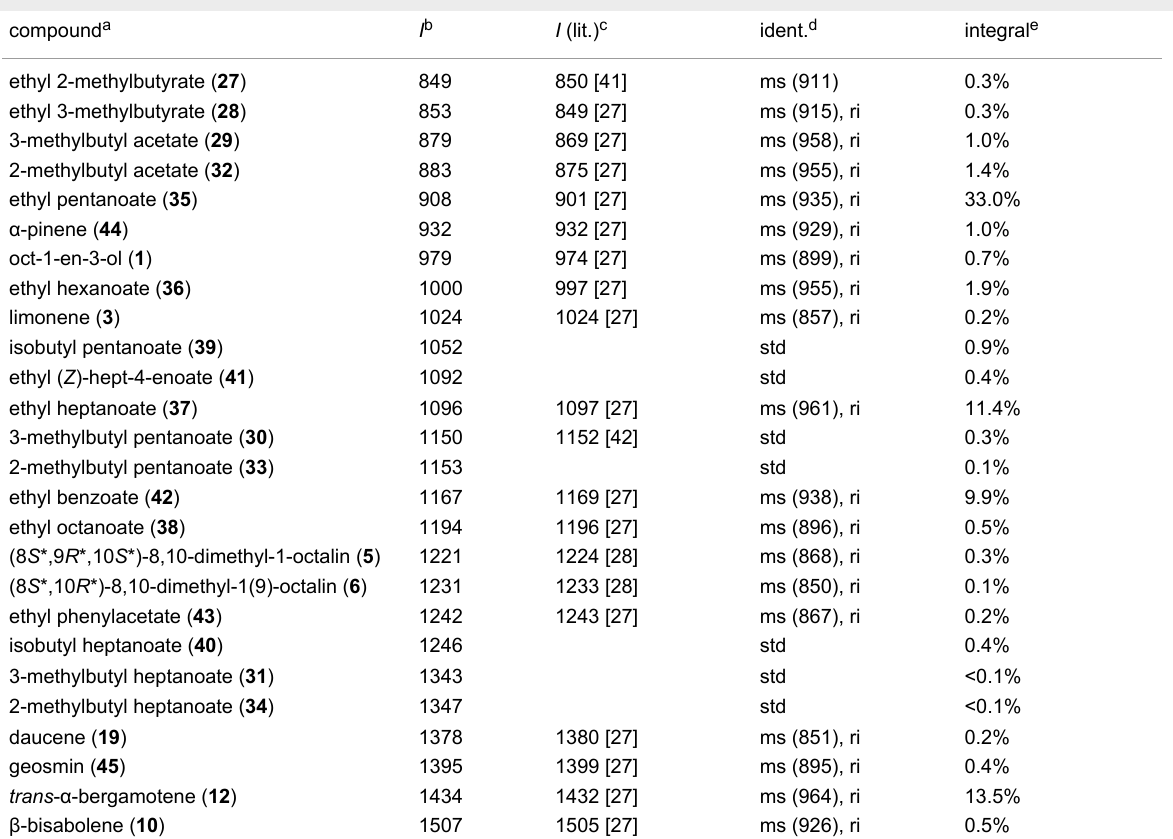
a Unidentified compounds and contaminants such as plasticisers are not listed. b Retention index on a HP5-MS GC column. c Retention index data from the literature. d Compound identification is based on matching mass spectrum to a library spectrum (ms, match factor given in brackets, identical mass spectra would produce a match factor of 1000), identical or closely matching retention index (ri), comparison to an authentic standard (std). e Percent of total peak area of the total ion chromatogram. The sum of integrals is lower than 100%, because unidentified compounds and contaminants are not